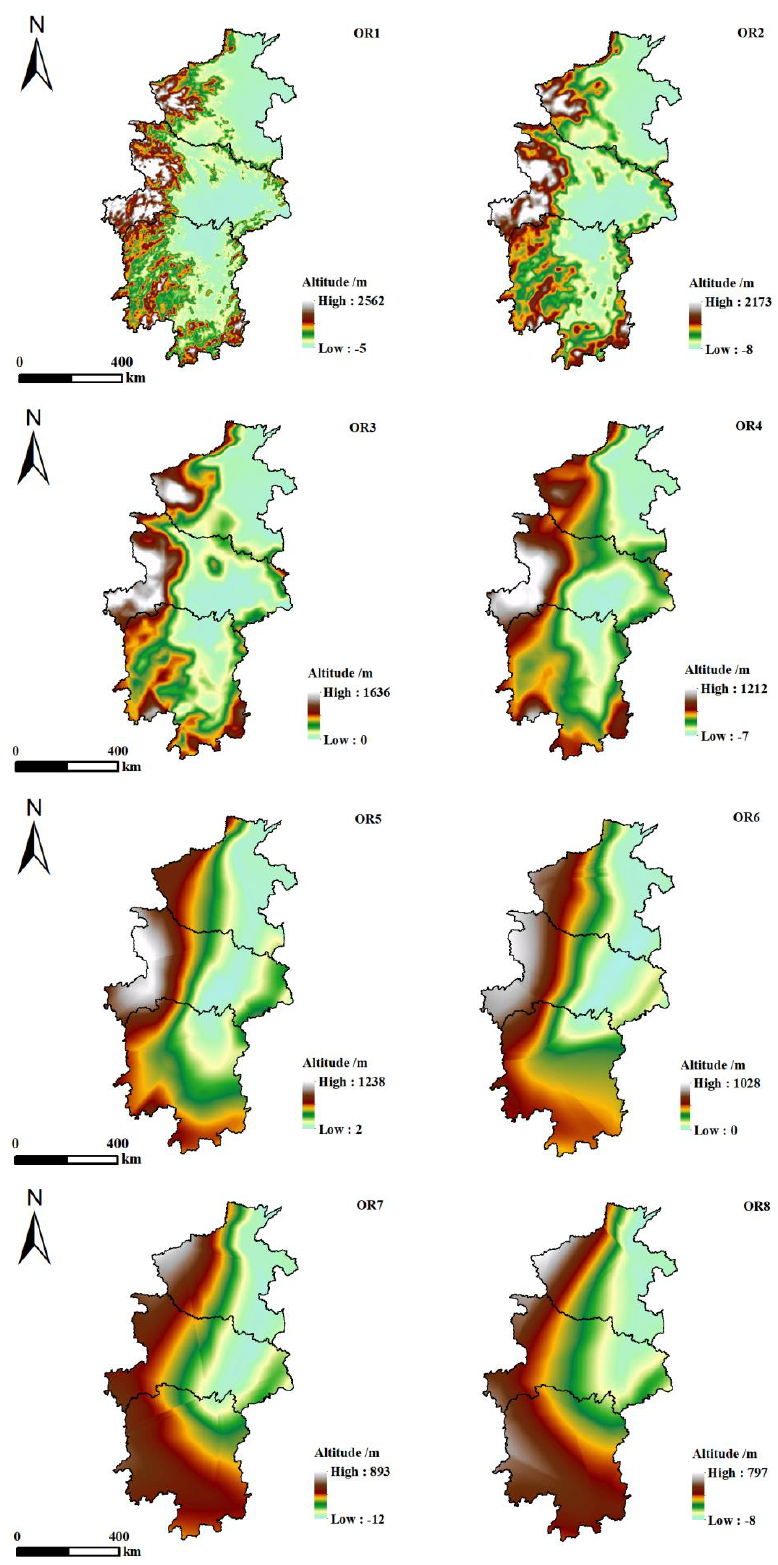
Figure 4. Terrain decomposition results of BEMD in Central China.